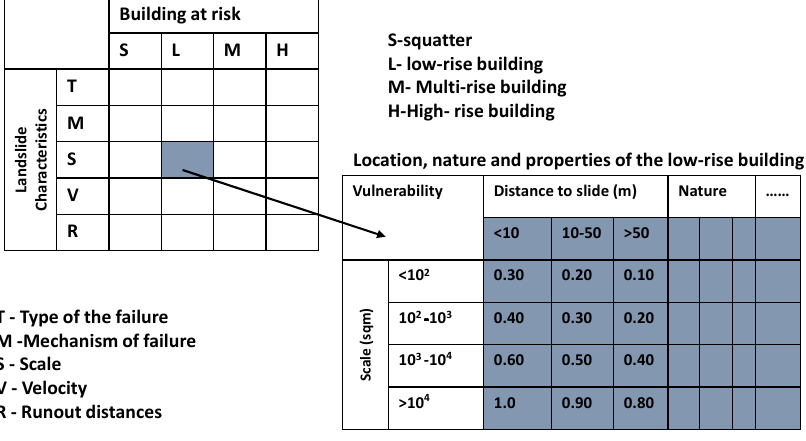
Figure 5. Structural vulnerability matrix [73].